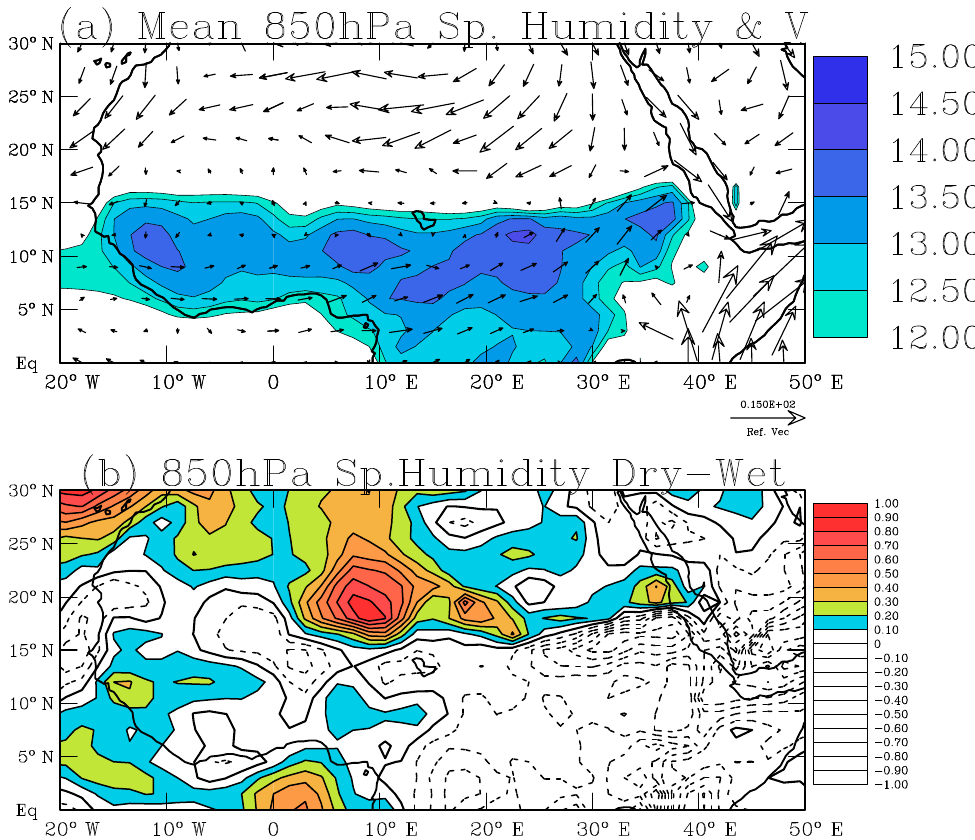
Figure 6. ( a ) Mean specific humidity and wind and ( b ) specific humidity in dry years–wet years at 850 hPa. Specific humidity is in g.kg − 1 and reference wind (magnitude = 10 m s − 1) is as shown